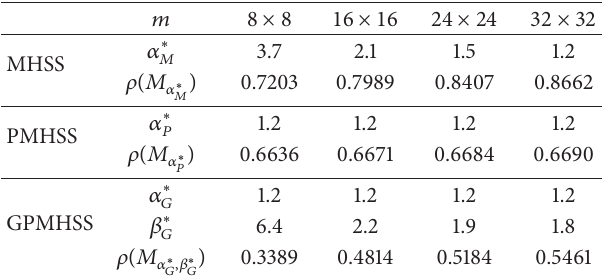
Table 3: RES, CPUs, and IT for MHSS, PMHSS, and GPMHSS with = 𝑃 = 𝑊 . 𝑃 = 𝑃 1 2